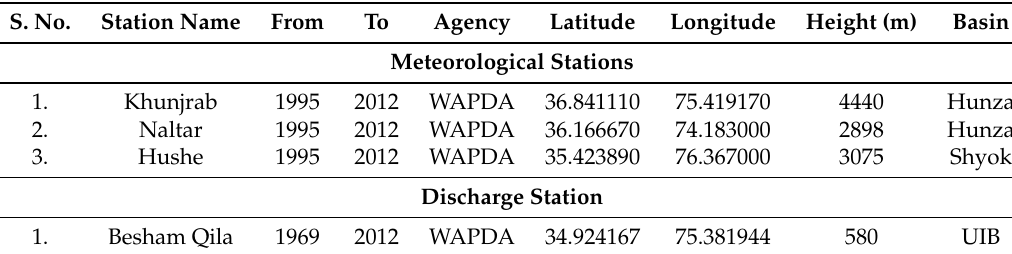
Table 1. High-altitude meteorological stations and outlet discharge